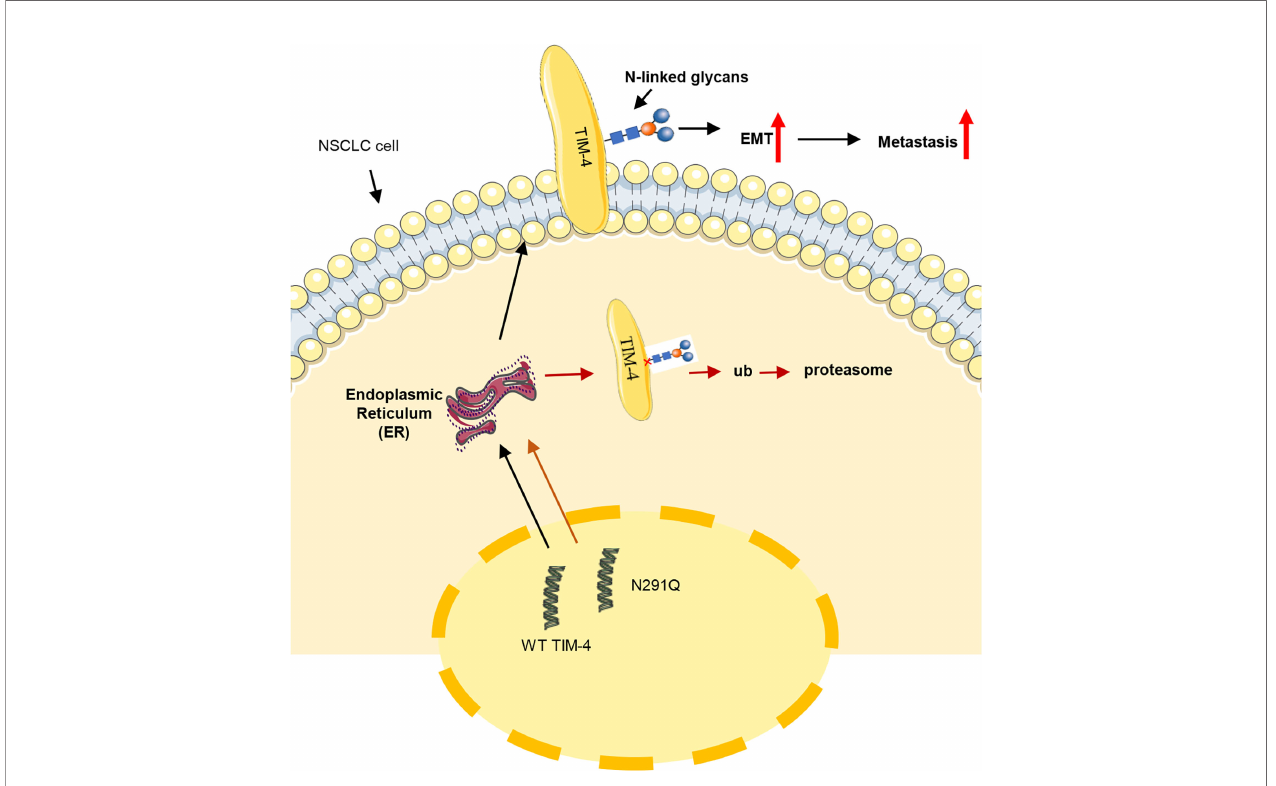
FIGURE 7 | Schematic representation of the role of TIM-4 N-glycosylation in NSCLC metastasis. TIM-4 is N-glycosylated at Asn291 and TIM-4 promotes NSCLC metastasis by modifying N-glycans at Asn291. When the N-glycosylation of TIM-4 is removed, the stability of TIM-4 protein is decreased and TIM-4 is more susceptible to degradation by ER-localized ubiquitin ligase-mediated ERAD. Thus, the function of TIM-4-mediated metastasis of NSCLC cells was